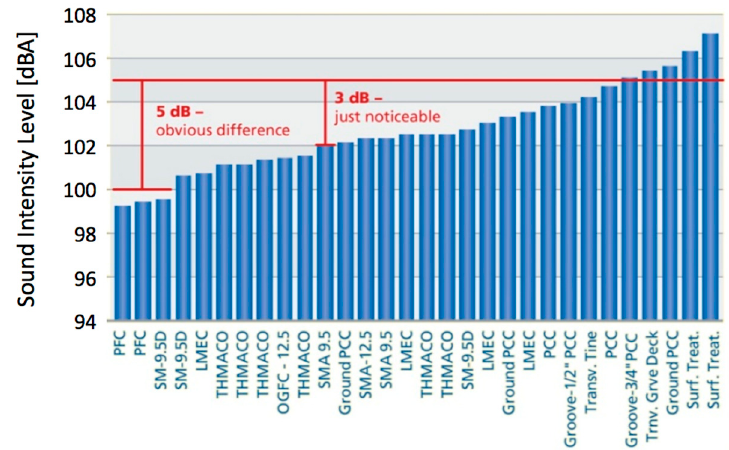
Figure 21. Acoustic performances of typical pavements in Virginia (modified from McGhee, 2012 [184], Page 14; reprinted under fair use provision).